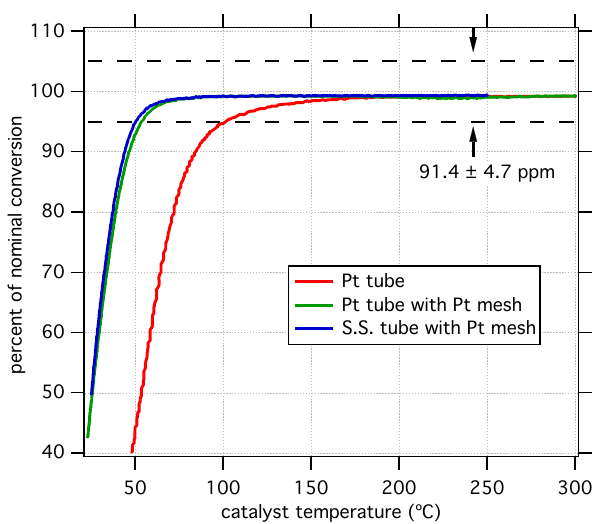
Fig. 2. Temperature dependence of conversion of H 2 to H 2 O for 3 catalyst designs. Water vapor was measured with an MBW 373LX hygrometer. For this experiment an H 2 cylinder with 91 . 4 ± 4 . 7ppm was used. Nominal conversion is calculated as measured mixing ratio/91 . 4 × 100%, and the range of observed conversion that would be within the uncertainty of the H 2 cylinder is